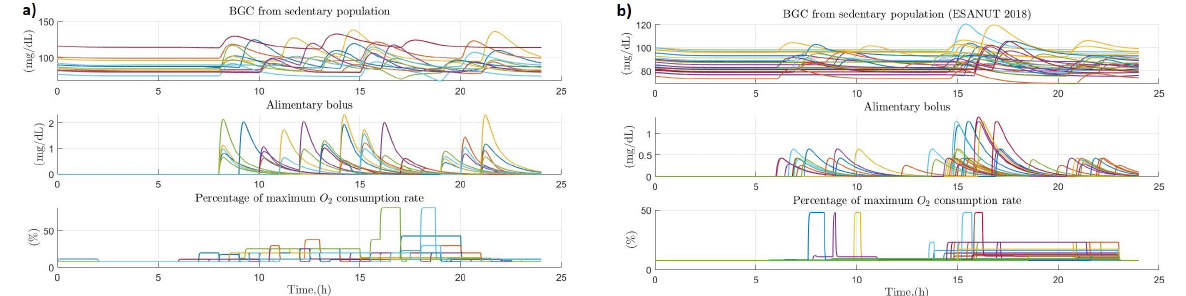
Figure 9. Effect of primary and secondary factors on blood glucose in sedentary populations. ( a ) Effect of diet and physical activity on glucose concentration in a sample of people with sedentary habits (sample of 20 healthy people); ( b ) Effect of diet and physical activity on glucose concentration in a sample of people with sedentary habits (ENSANUT 2018 subsample)